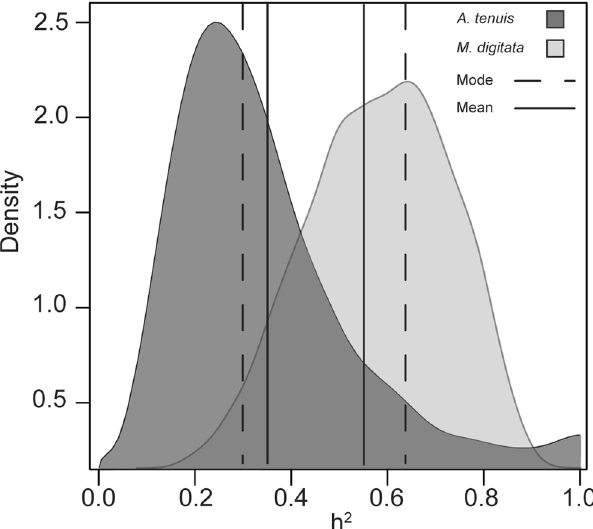
Figure 5. Posterior distributions of the heritability estimates for A . tenuis (dark grey) and M . digitata (light grey) generated from Bayesian MCMCglmm models. Dashed and full lines correspond to distribution modes and means,